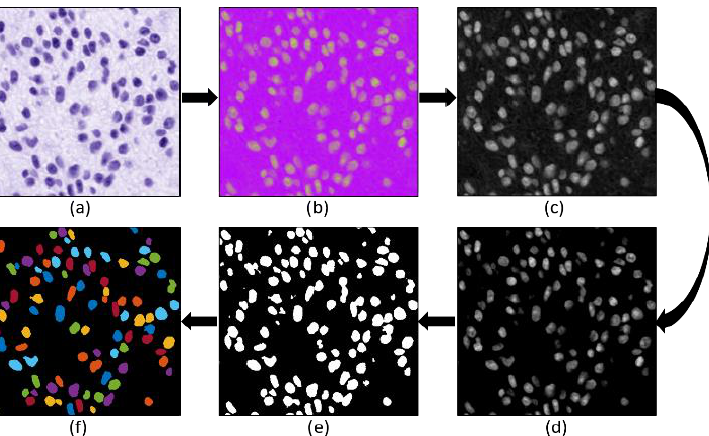
Figure 5. The complete process for nuclear segmentation of cancer cells. ( a ) Hematoxylin channel extracted after performing stain deconvolution. ( b ) HSI color space converted from ( a ). ( c ) Satura- tion channel extracted from ( b ). ( d ) Contrast adjusted image extracted from ( c ). ( e ) Binary image after applying global thresholding on ( d ). ( f ) Nuclei segmentation after applying the watershed al- gorithm on ( e ). Some small objects and artifacts were removed before and after applying the water- shed algorithm.